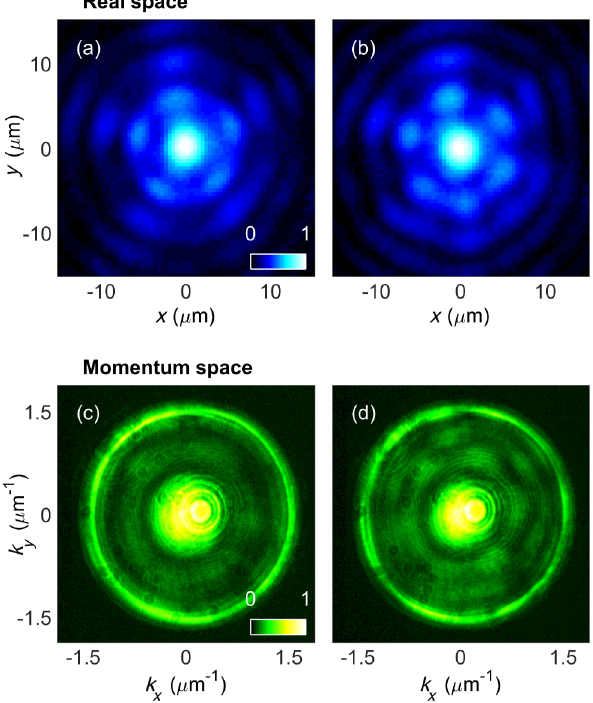
FIG. 3. Real- and momentum-space patterns. Moving the beam waist position relative to the sample surface by adjusting the focus of the excitation objective allows the transformation from a pentagon (a,c) to a hexagon (b,d). Bright lobes can be seen in both real space (upper) and momentum space